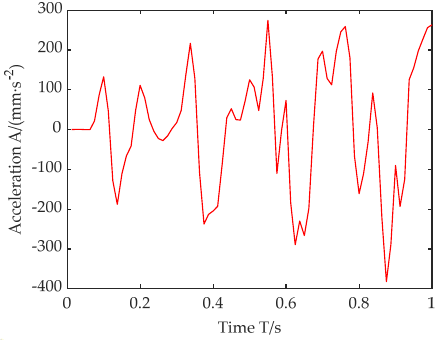
Figure 8. Roadside acceleration response curve.